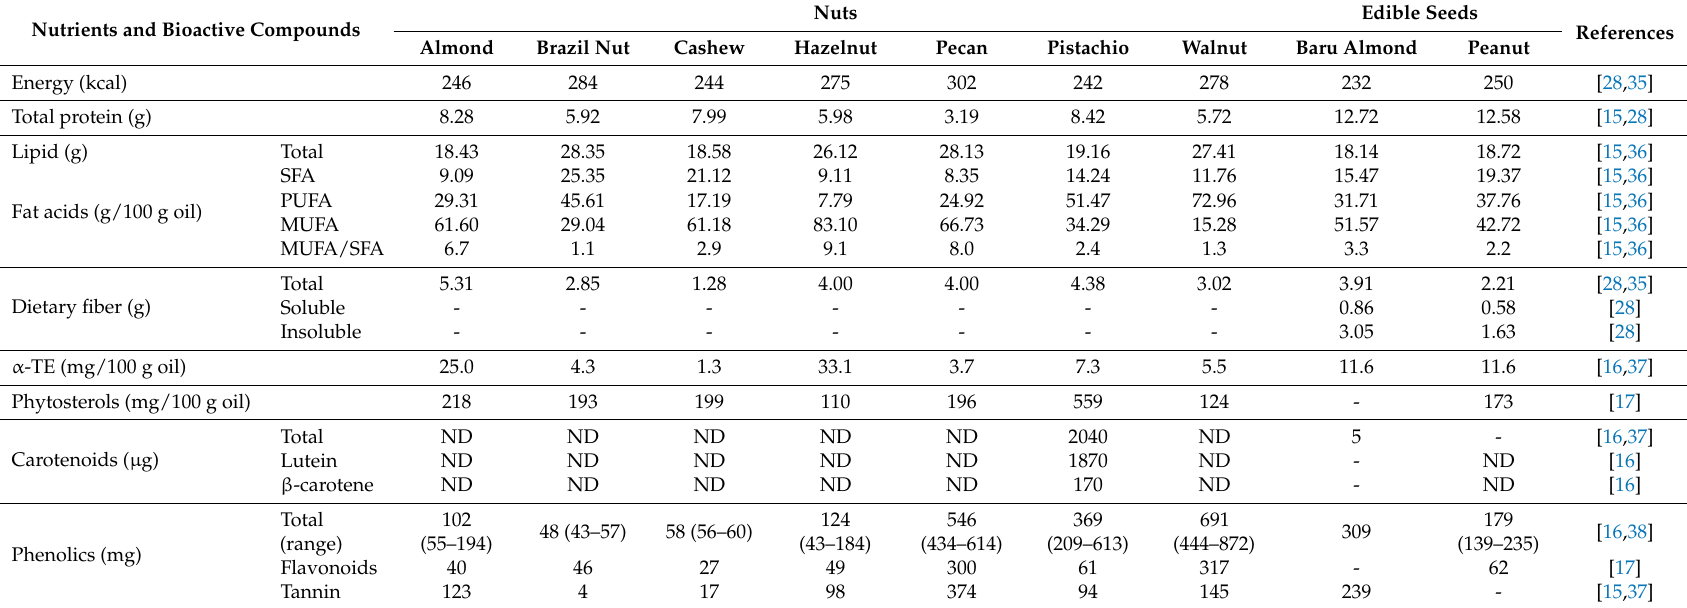
Table 2. Nutrients and bioactive compounds of selected nuts and edible seeds per serving of 42.5